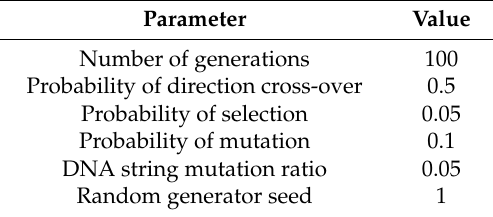
Table 5. Multi-objective genetic algorithm (MOGA) parameters used.